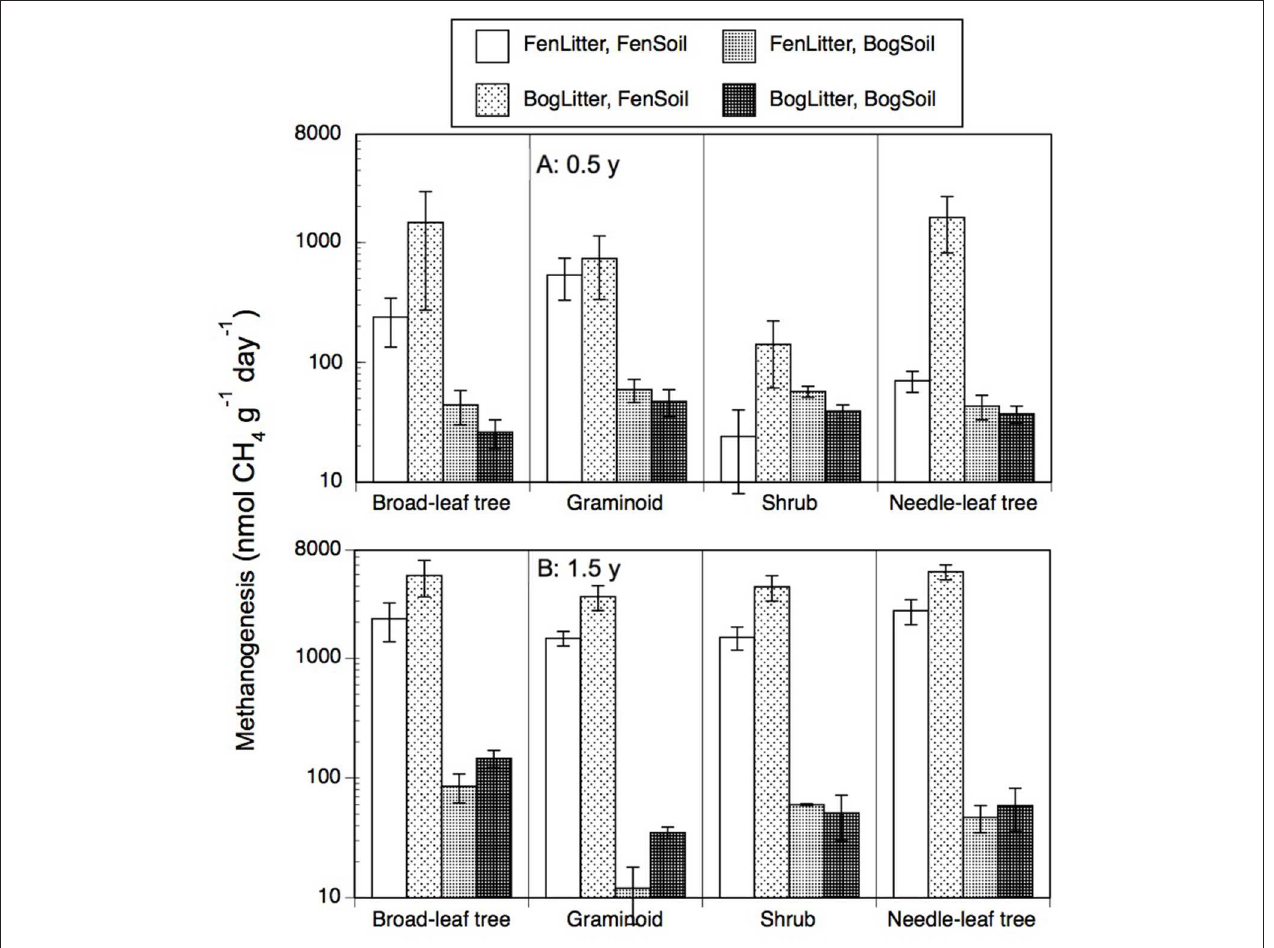
( Figure 4 ). In contrast, the peat soils without added leaf litter had rates of < 20 nmol g − 1 d − 1 . Across the nine species and two types of soil, rates were greater with older 1.5-years old residue (1,634 + 2,235 nmol g − 1 d − 1 , n = 72) than with the less decomposed across the nine species and two types of soil, rates were greater with residue from decay in the bogs (1,405 + 2,272 nmol g − 1 d − 1 , n = 72) than from decay in the rich fens (566 + 1,049 nmol g − 1 d − 1 , n = 72). For most of the plant growth forms, the largest rates occurred with residue from decay in the bogs placed on the surface of fen soil.